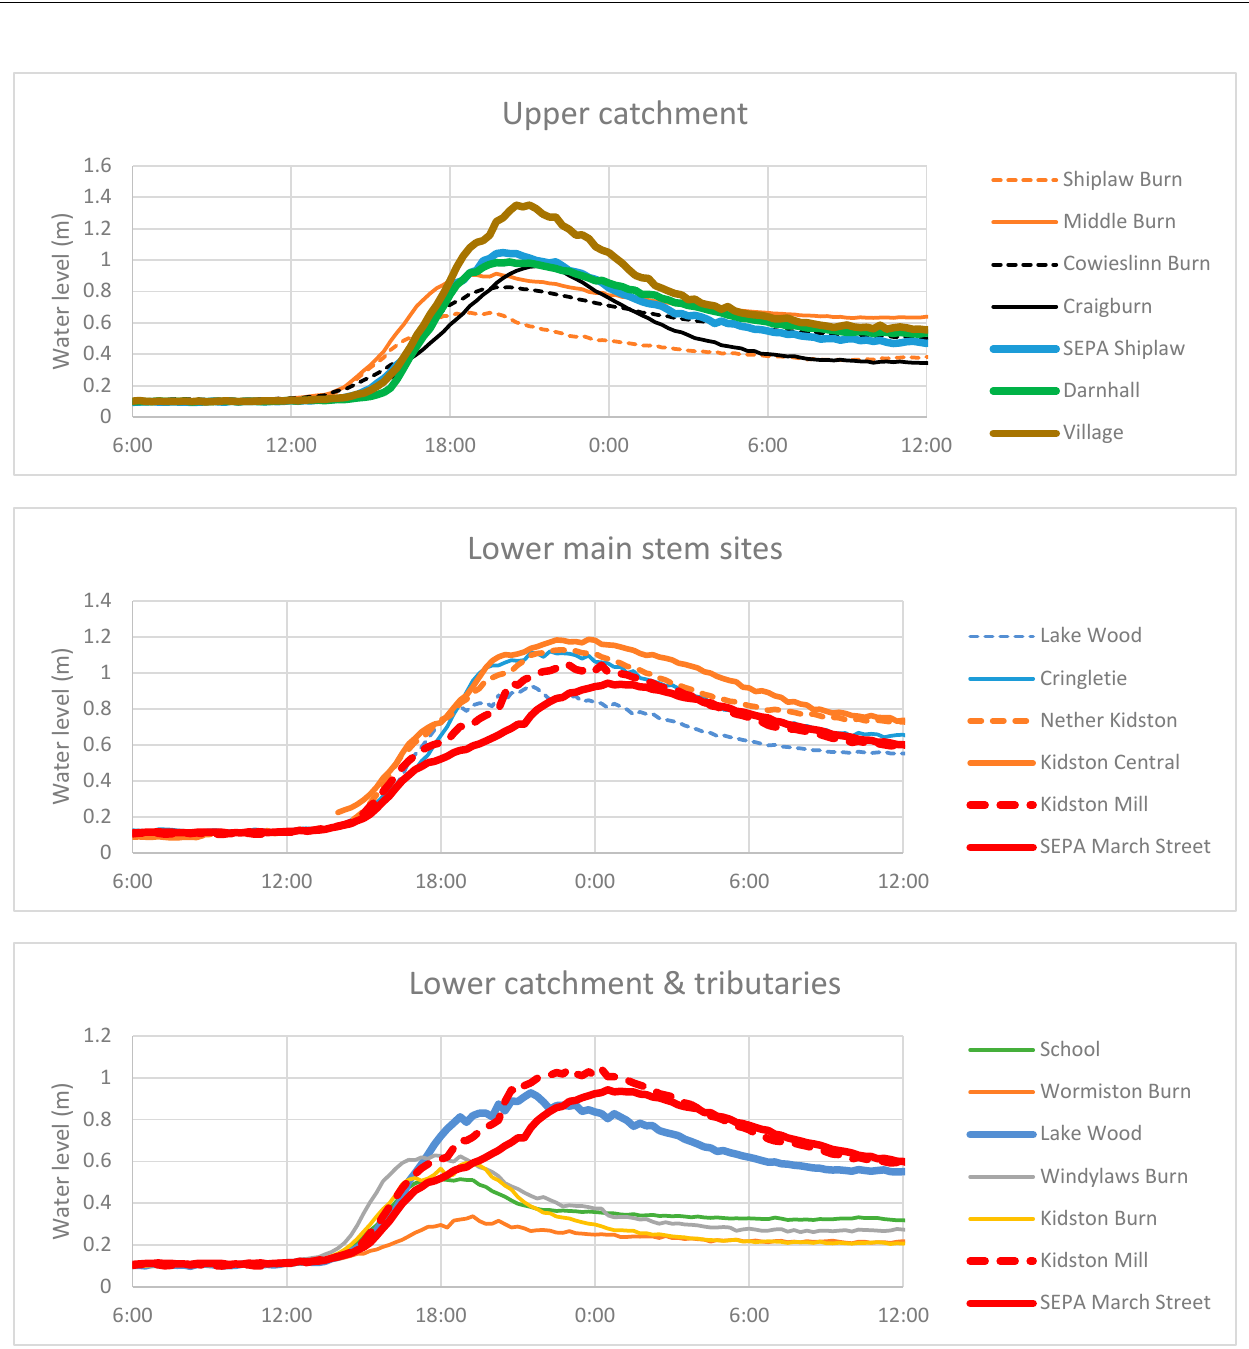
Figure 5. Water level hydrographs for main stem and tributary gauges, 4–5 December 2020 (levels shown relative to a common starting level for display purposes). See also Figure 1 for location of individual gauging stations.